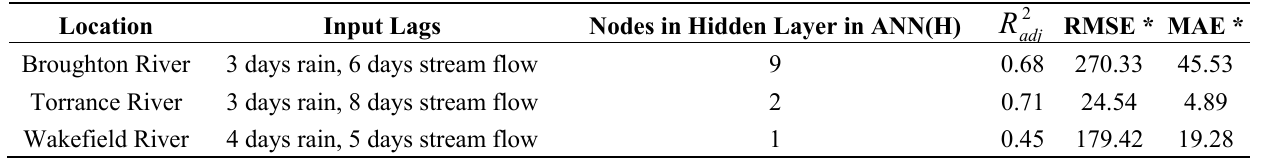
Table 7. Best prediction model based on 2 training data.